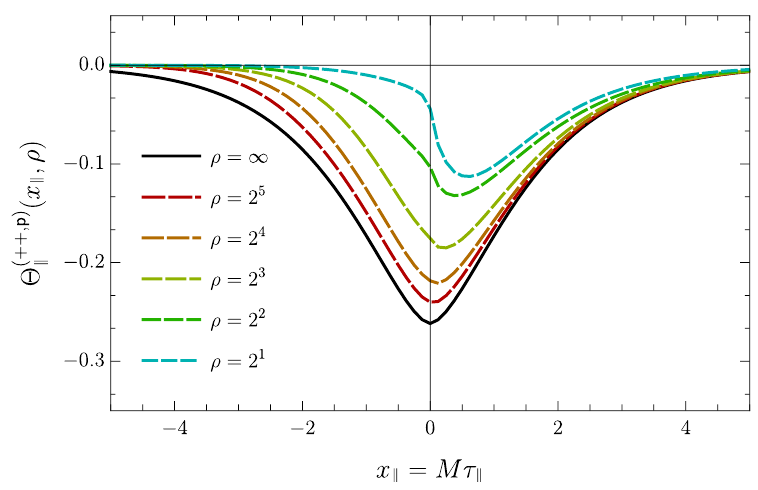
(++ , p ) ( x , ρ ) of the free energy for different values Figure 16: Scaling function Θ of aspect ratios ρ ≥ 2. The scaling function converges against the limiting case of ( x ) for growing ρ . At about ρ ≈ 2 the behaviour starts to a periodic thin film Θ b change dramatically, see Fig.